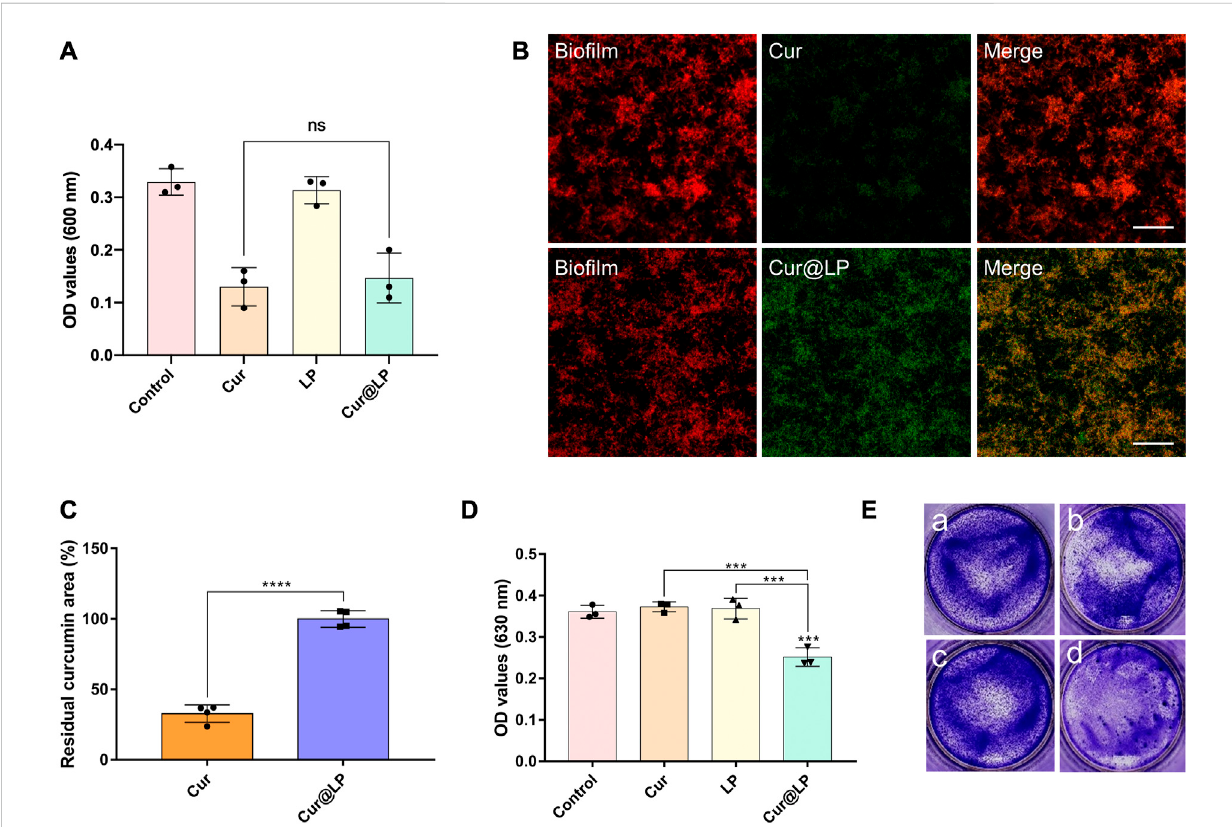
FIGURE 5 (A) OD value of the S. mutans planktonic culture after being treated with PBS, Cur, LP, or Cur@LP with photoactivation. The images (B) and quanti fi cation (C) ofCurorCur@LP(green)adhesionon S.mutans bio fi lm(stainredwith STYO 59).TheOD value (D) and crystal violetstainingimages